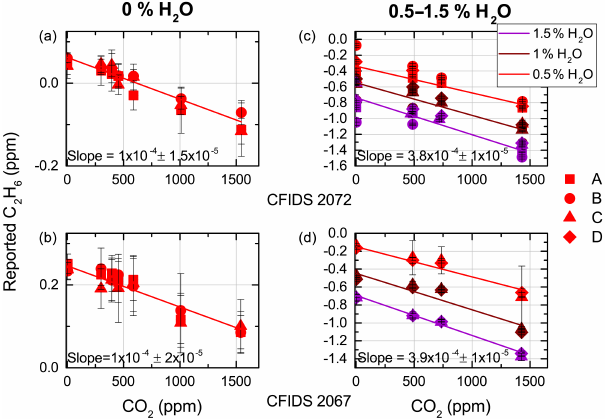
Figure 6. Relationship between reported C 2 H 6 and concentration changes of CH 4 for both instruments at 0ppmC 2 H 6 (within our instrumental precision). For each plot, the bottom axis indicates the increase in concentration of the targeted gas. The vertical bars in each plot denote the standard deviation of each point. The legend denotes repetitions of the experiment. Plots (a) and (b) are at 0% H 2 O. The R 2 values are 0.4 and 0.6 for instruments CFIDS 2072 and 2067. Plots (c) and (d) show the response at 1% H 2 O. These two plots have a R 2 value of